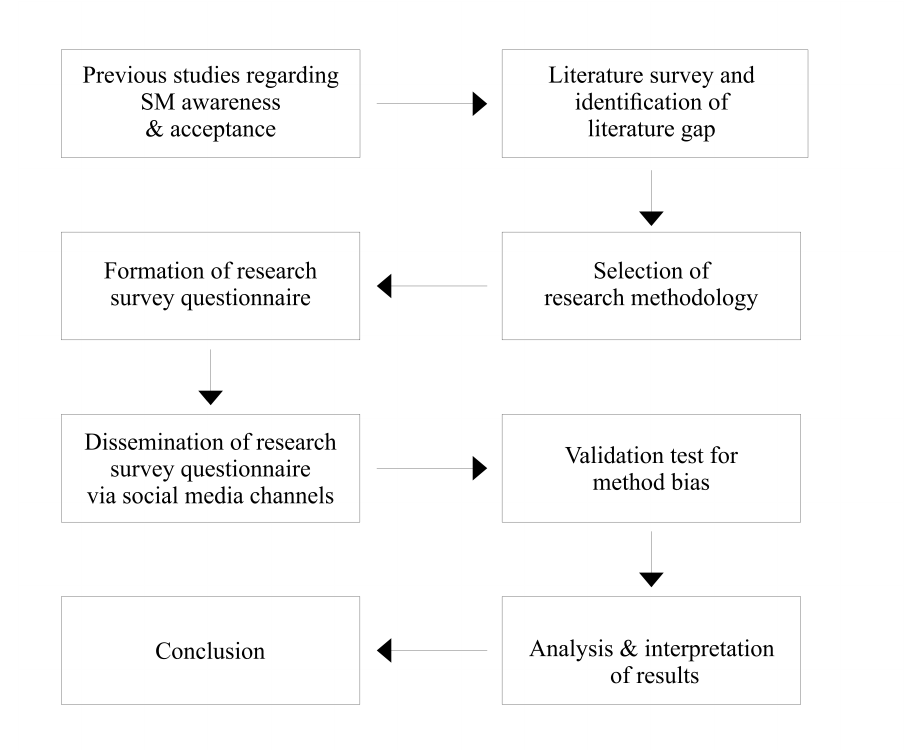
Figure 1. Research